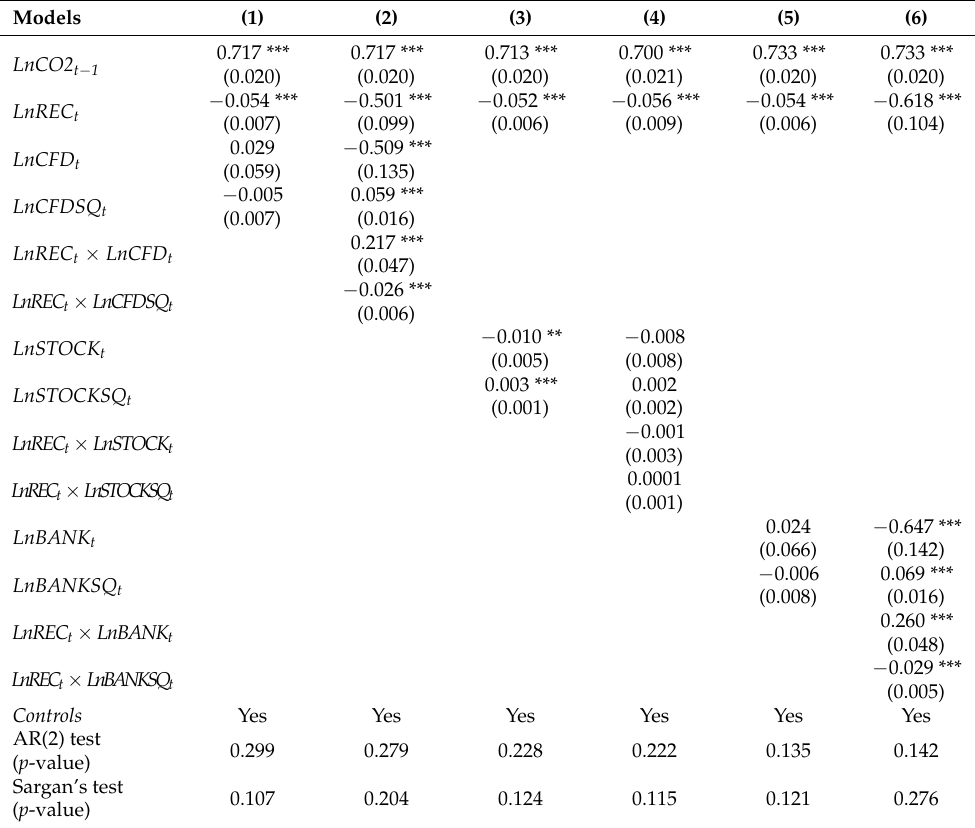
Table A3. Results of GMM model with LnREC and with the squared term of financial development.